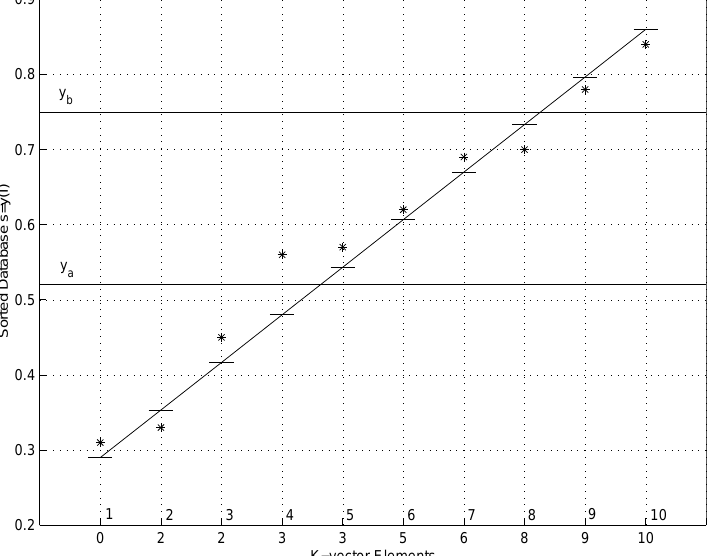
Figure 7. Example of k -vector construction (reprinted from